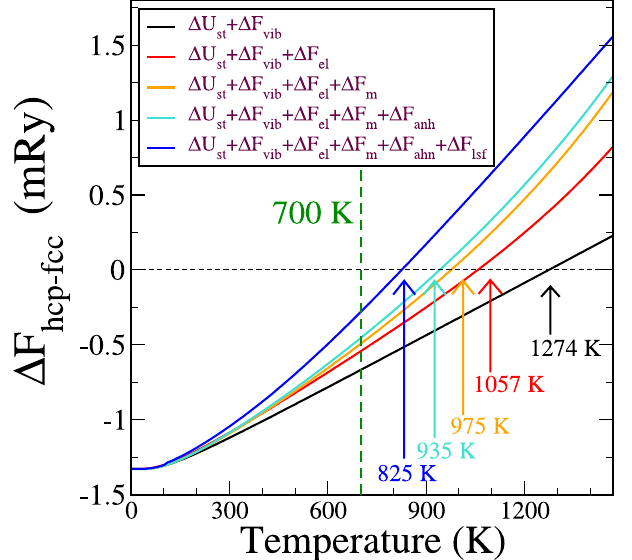
Figure 3. Temperature dependence of the free energy differences. The solid black curve contains the contribution from the static energy and the phonon free energy, the red one adds the electronic contribution, the orange one adds the magnetic free energy, the cyan one contains as well a quasi-harmonic contribution and the blue one contains an estimation of the LSF contribution.